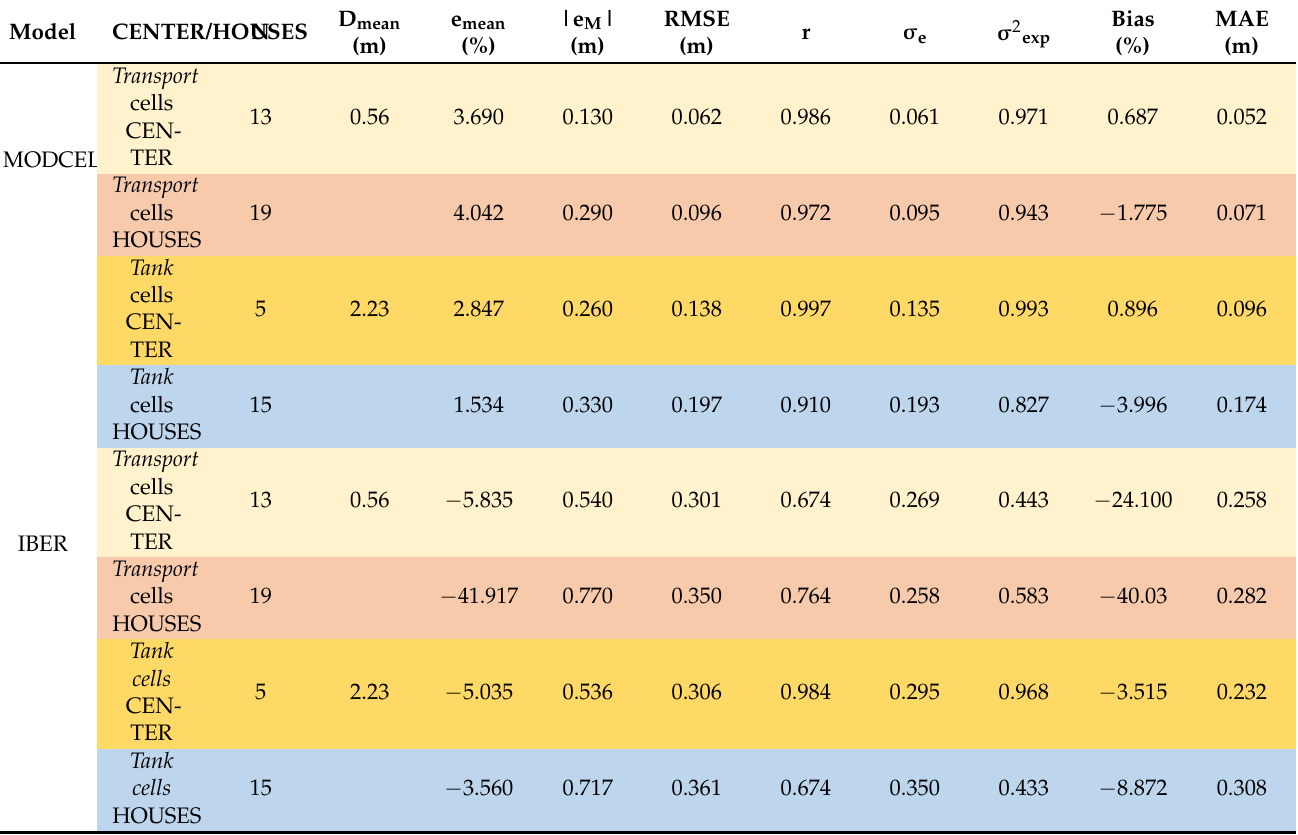
Table 4. Goodness-of-fit indicators of the MODCEL and IBER models in cells CENTERS and single HOUSES (compare lines with a given color between MODCEL and